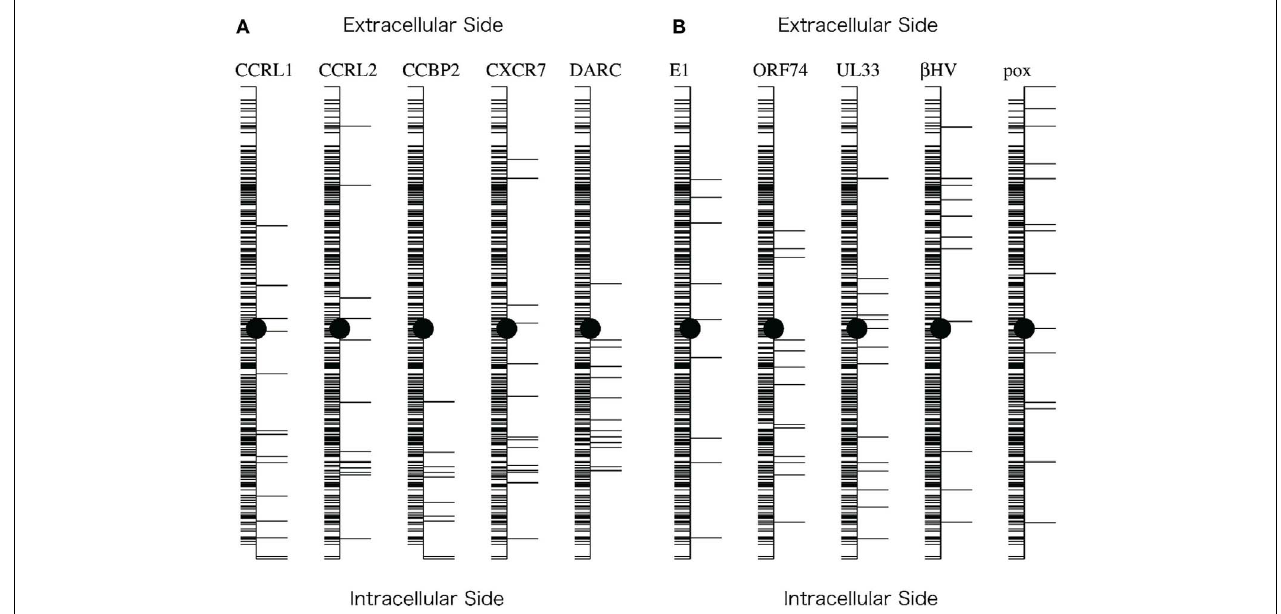
Methods.” In each figure, the vertical line indicates the axis. Horizontal lines on the right side of the axis indicate the projected positions of the residues corresponding to the sites selected based on the KL information values. Horizontal lines on the left side indicate the projected positions of the remaining residues.The filled circles indicate the midpoint of the axis.